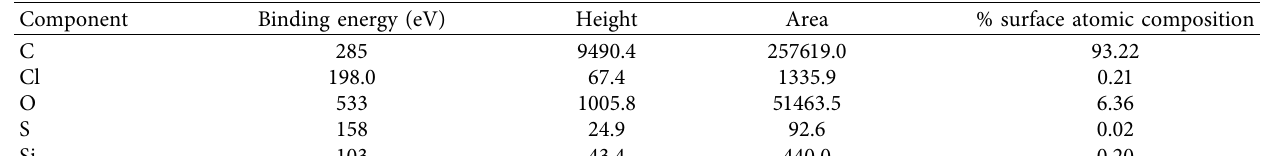
Table 4: XPS elemental analysis (% surface atomic composition).